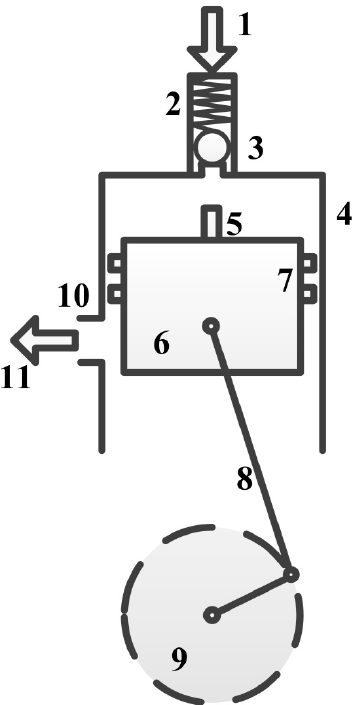
Figure 9. Structure of single-valve piston expander ( 1 ) intake; ( 2 ) spring; ( 3 ) ball valve; ( 4 ) cylinder; ( 5 ) push rod; ( 6 ) piston; ( 7 ) piston ring; ( 8 ) connecting rod; ( 9 ) crankshaft; ( 10 ) exhaust port; and ( 11 ) exhaust.